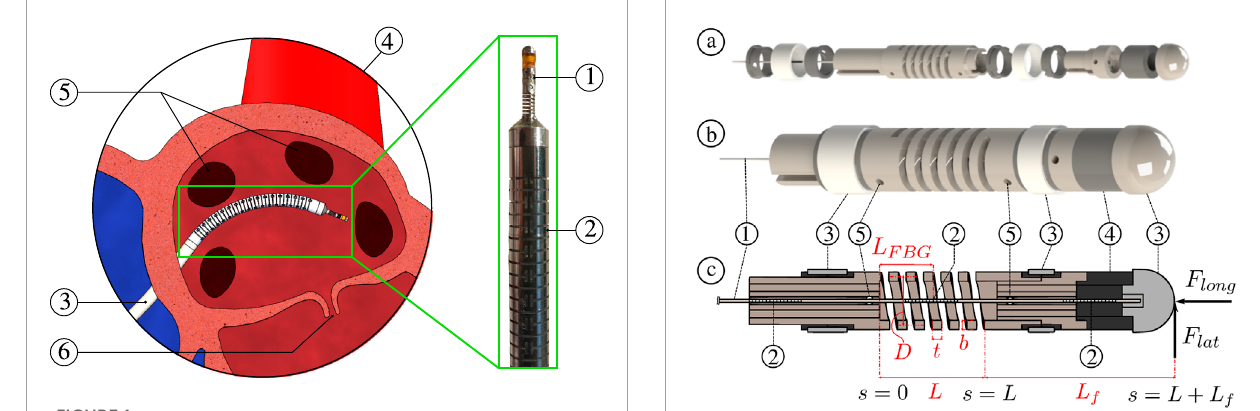
FIGURE 1 Catheter ablation scene: ① catheter tip force sensor, ② actuatable catheter, ③ medical delivery sheath, ④ zoomed-in view of the left atrium, ⑤ pulmonary veins, and ⑥ mitral valve.